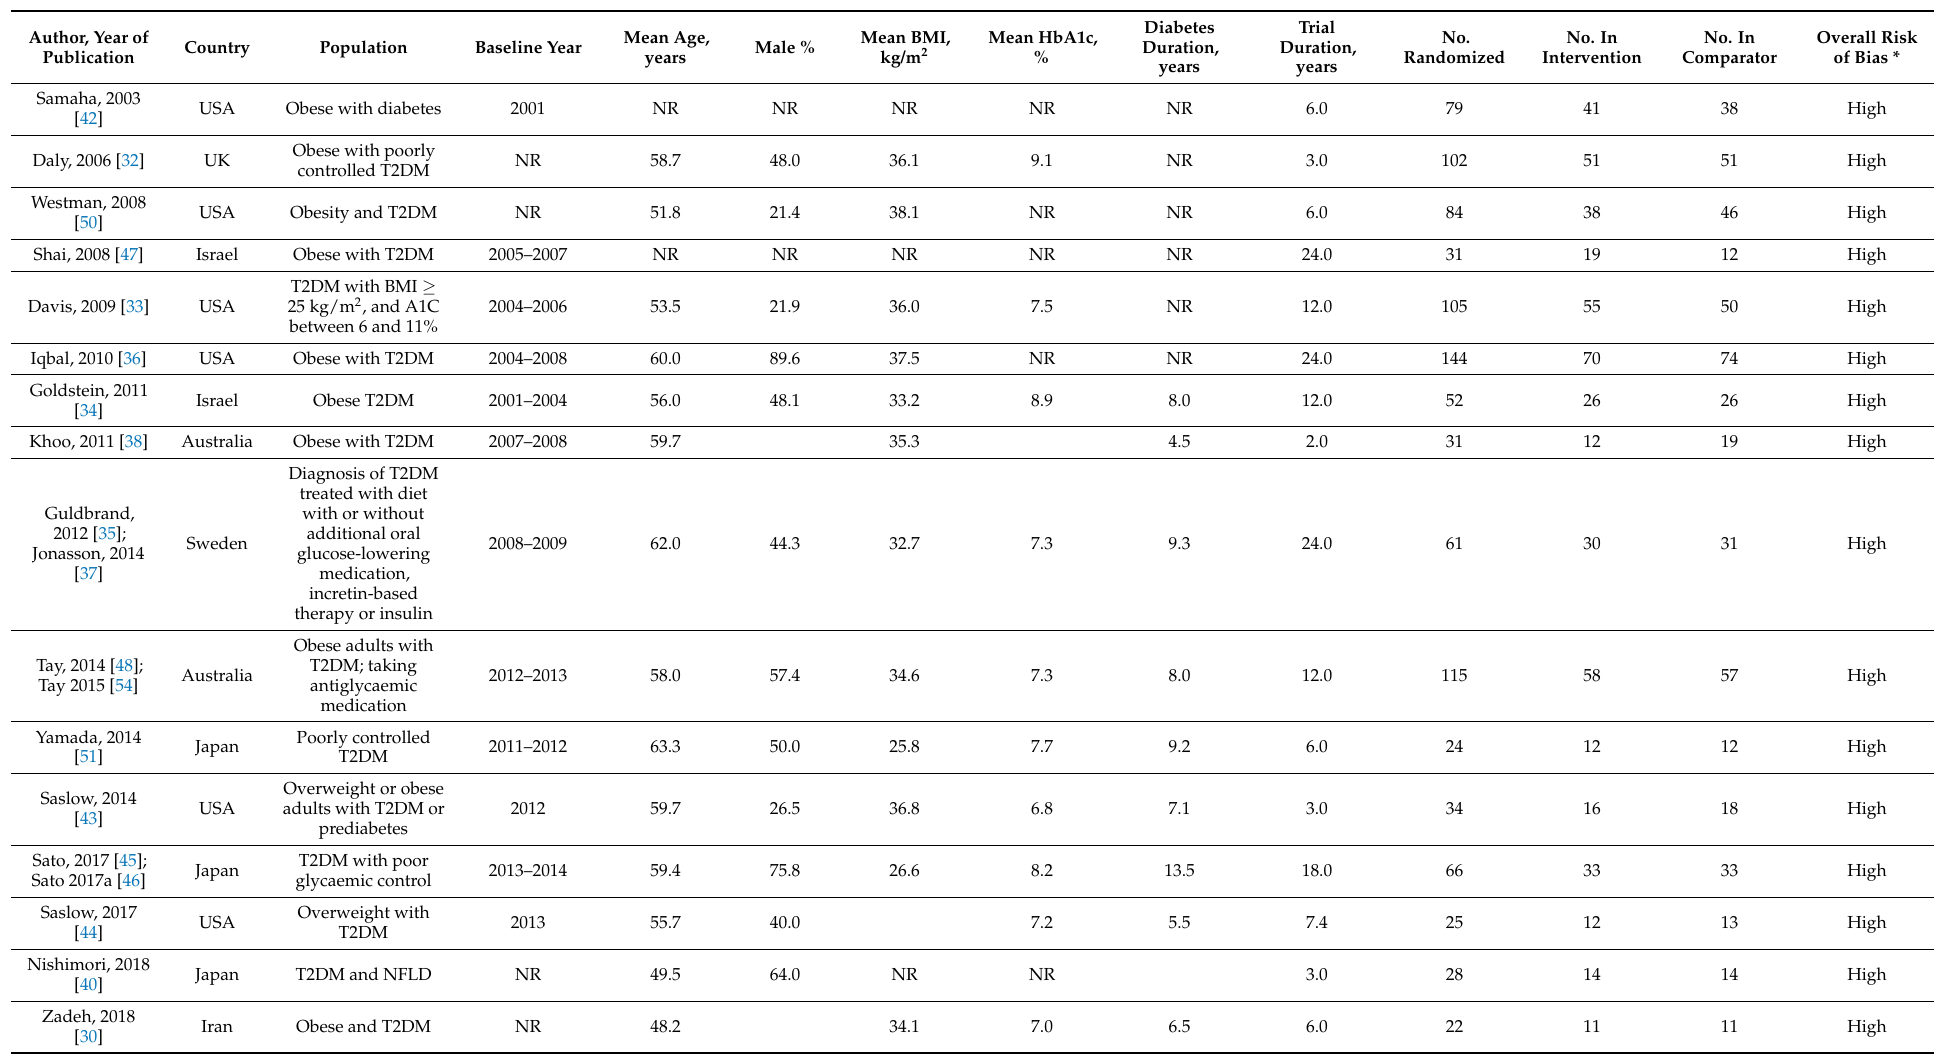
Table 1. Characteristics of included